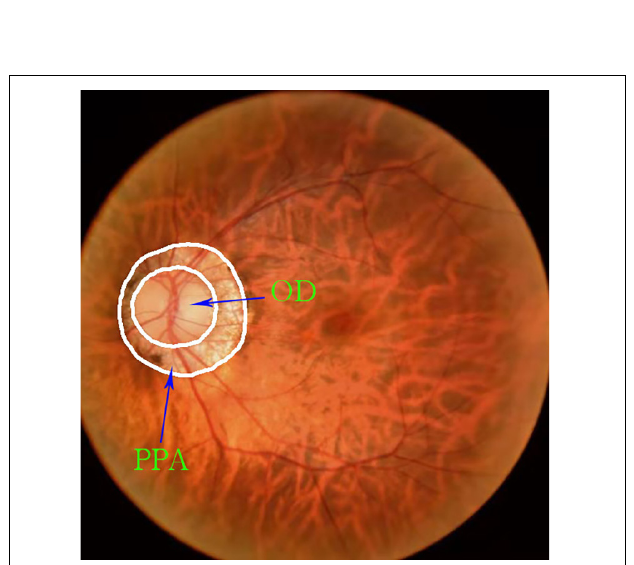
FIGURE 2 | Relationship between the position of the parapapillary atrophy and optic disc: The part inside the white circle in the middle is optic disc, and the ring part between the two white circles is parapapillary atrophy.